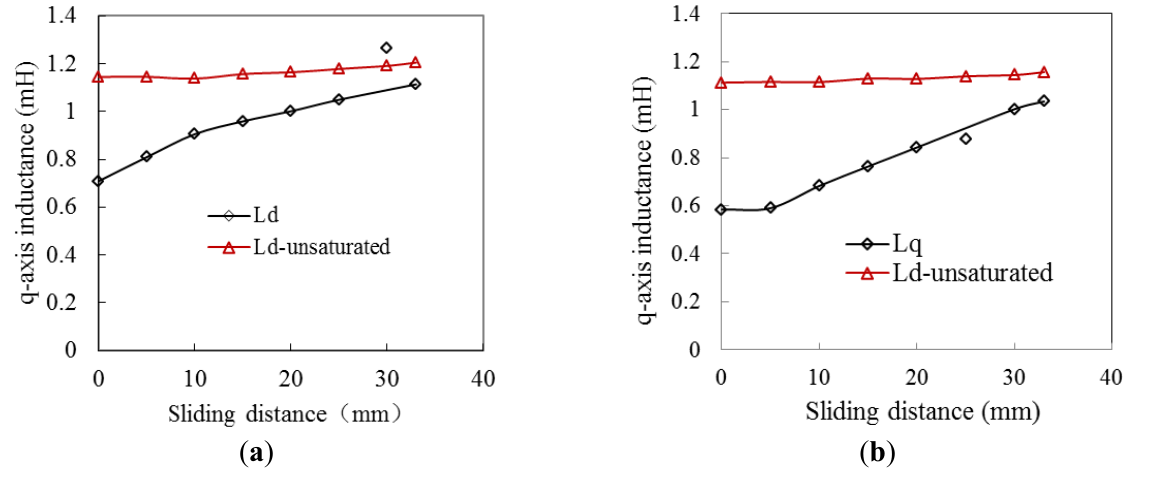
Figure 12. The d - and q -axis inductances versus the sliding distance of the PMs: ( a ) L